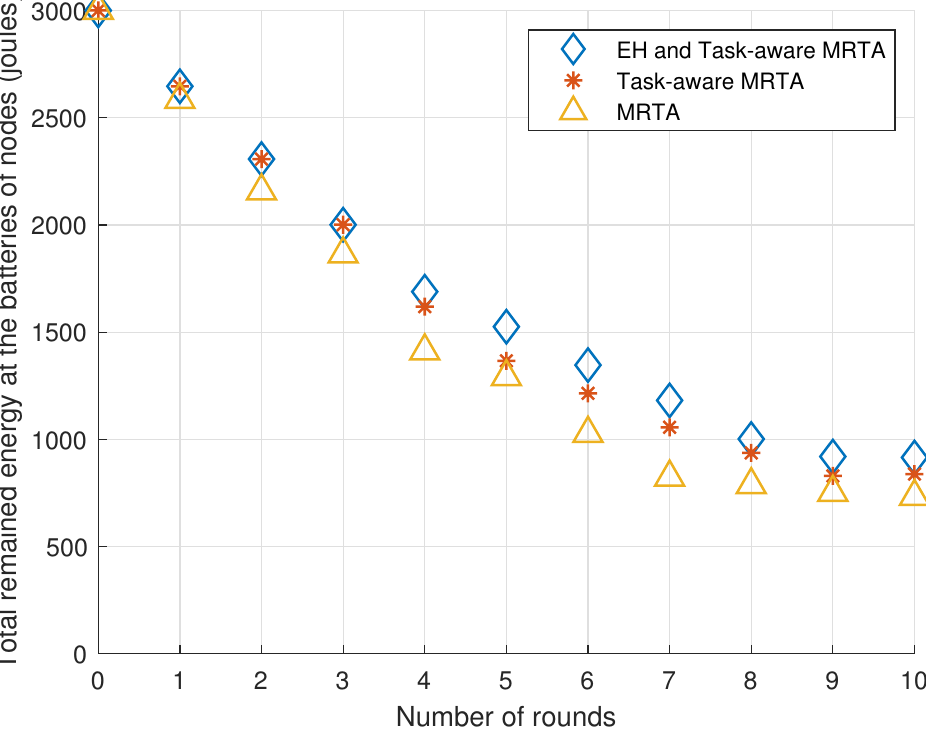
Figure 3. Total remaining energy in the batteries of the 5 i.i.d. EH robot nodes versus the number of rounds under i.i.d. EH